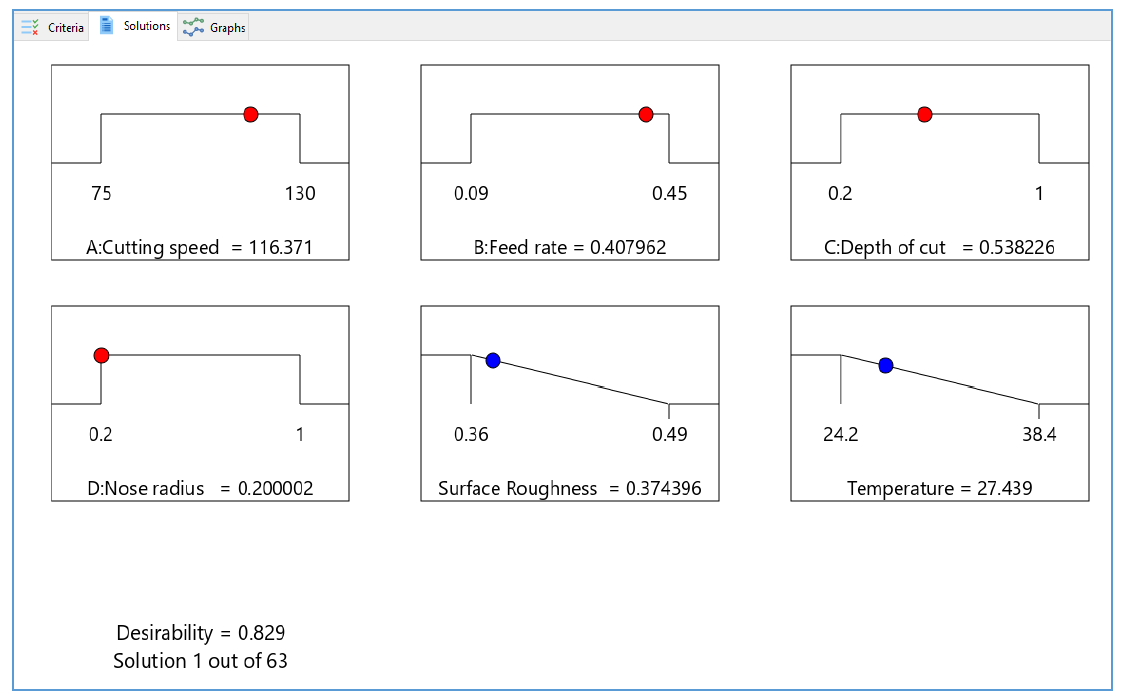
Figure 7. Optimal parameter ramps function graphs and combined optimization.